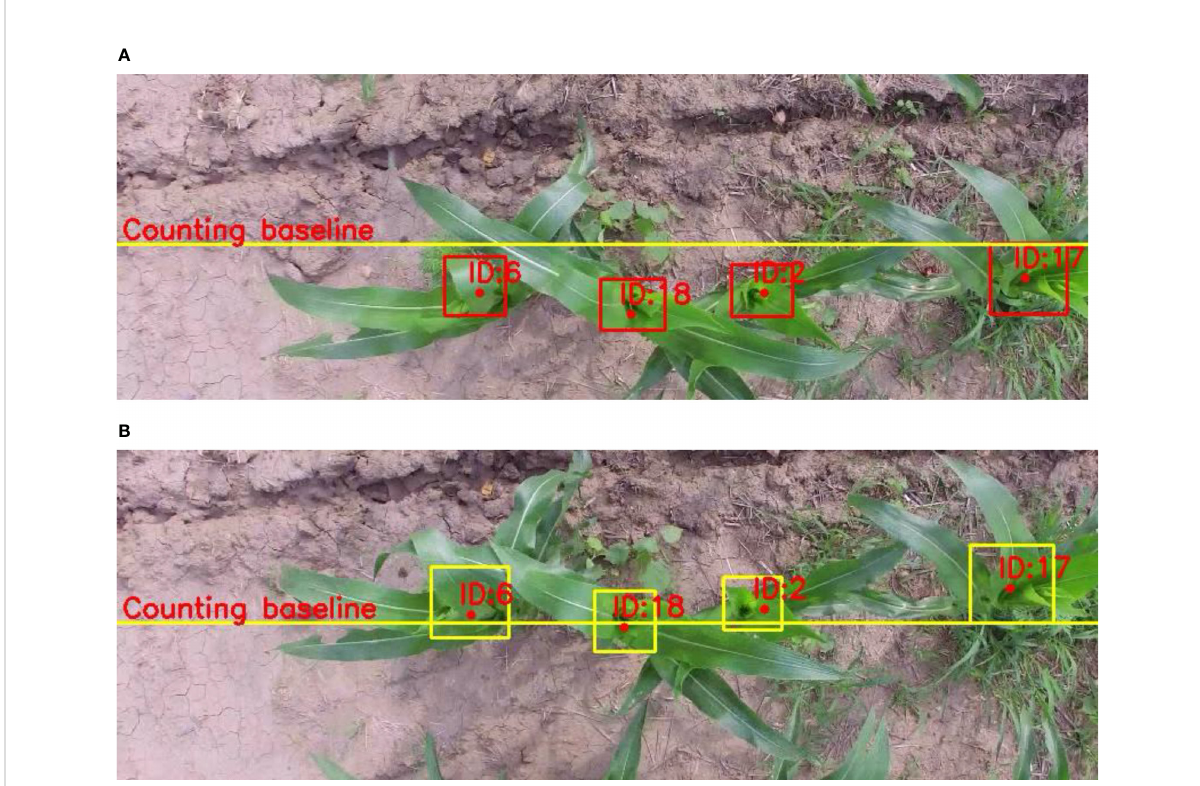
FIGURE 5 Demonstration of the counting baseline for counting. The yellow line is the counting baseline. The top shows the n th frame; the bottom shows the n+i th frame. (A, B) shows the n-th frame and n+1 th frame,